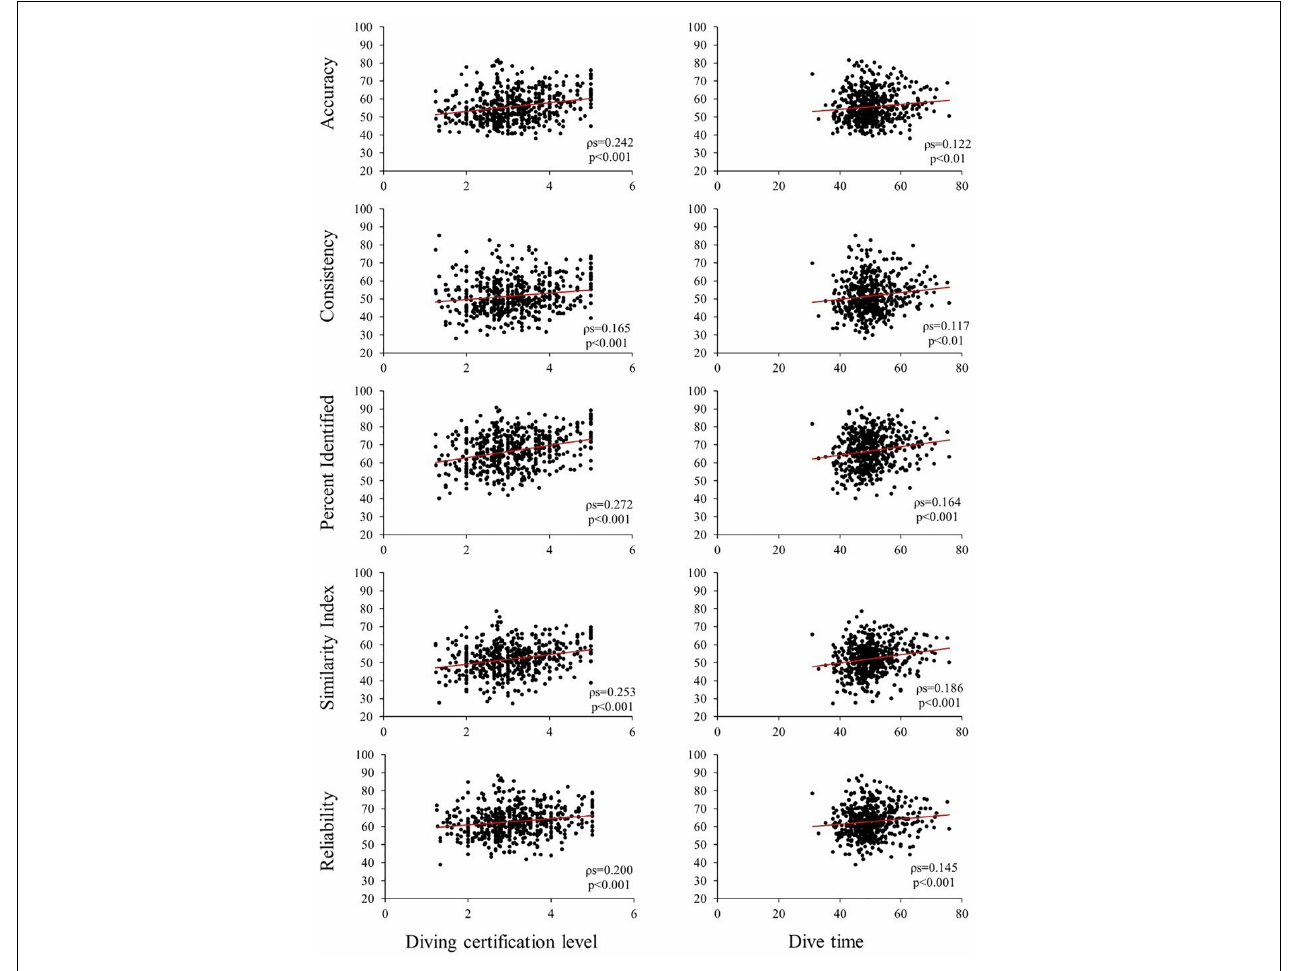
FIGURE 4 | Significant correlations between the studied reliability parameters (Accuracy, Consistency, Percent Identified, Similarity Index, and Reliability) and the independent variables Diving certification level and Dive time. Results based on the 513 validation trials. Indicated in red the trendline of the correlations. ρ s = Spearman coefficient